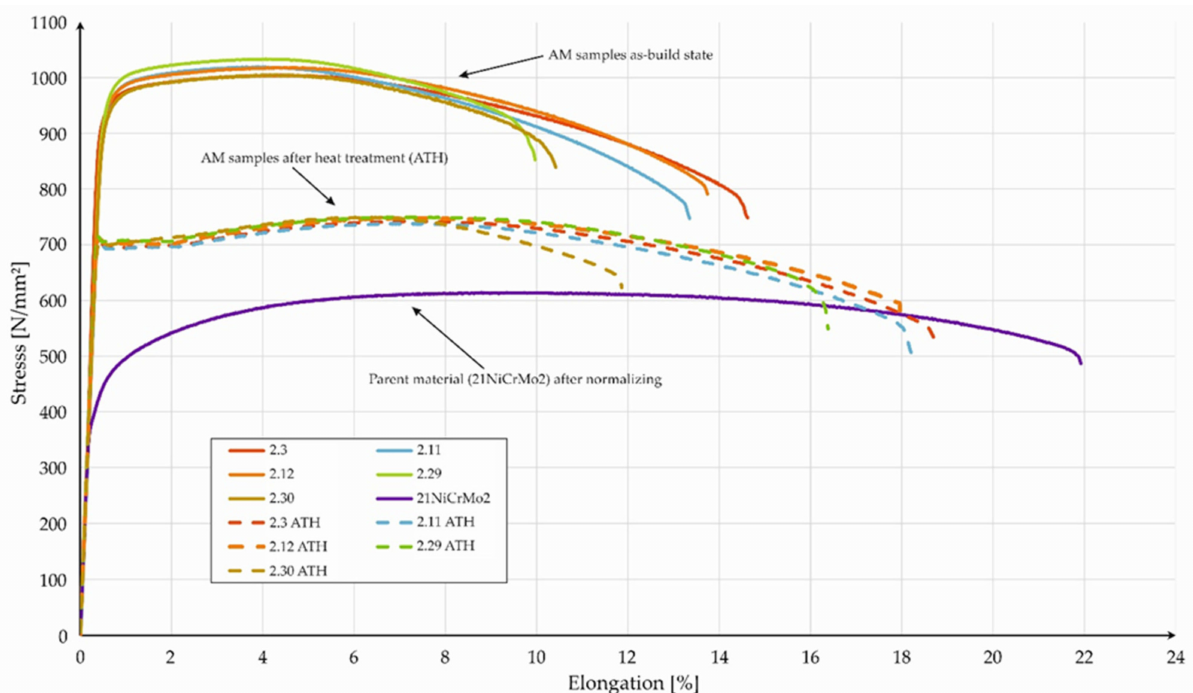
Figure 8. Stress-strain curves of the PBF-LB/M samples (as-built and after heat-treatment—AHT) compared with the parent materials (after